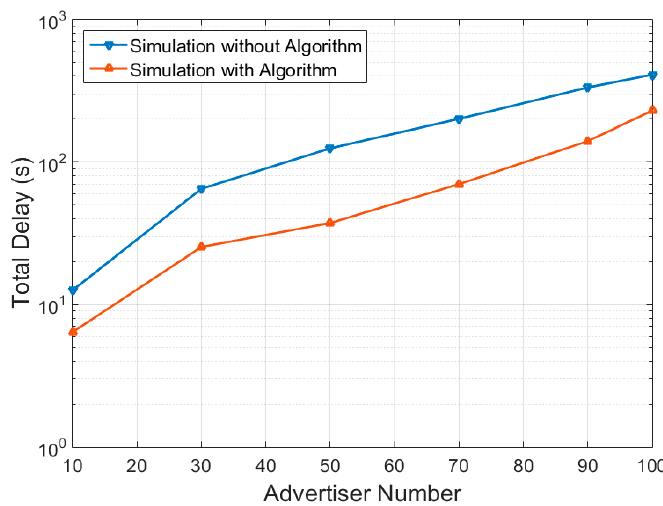
Figure 10. Total delay for advertiser discovery by the scanner in the worst-case scenario.